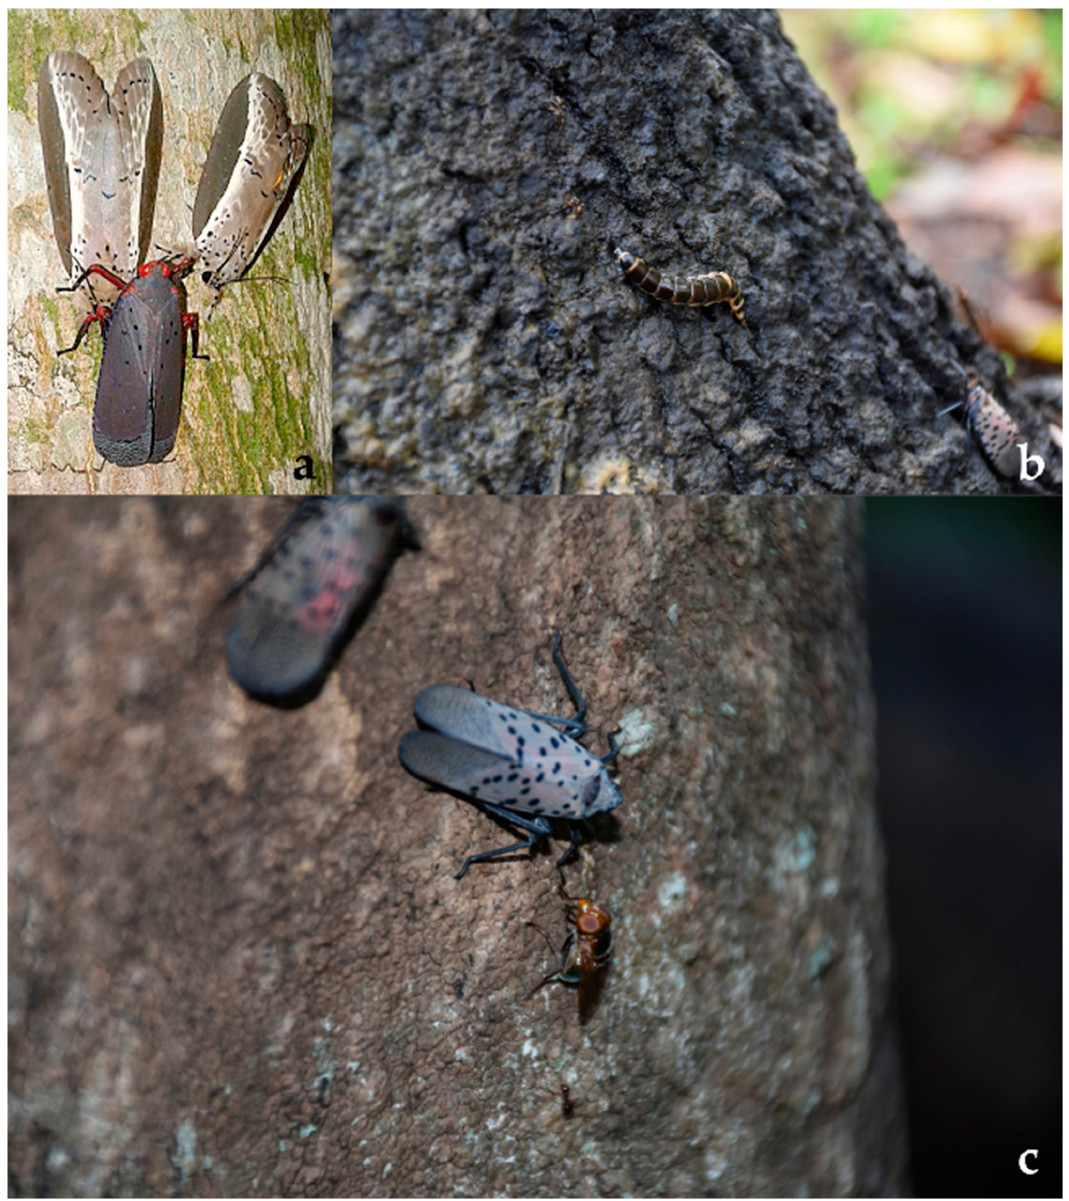
Figure 10. Fulgoridae: ( a ) Kalidasa nigromaculata (Gray, 1832) tended by Lepidoptera: Nolidae: Eligma narcissus (Cramer, 1775), Laos: Vientiane, 17°58 ′ N 102°36 ′ E, 10.08.2017, adult on tree trunk, obs. K. Keomani; ( b ) Lycorma delicatula (White, 1845) tended by Coleoptera indet., USA: Pennsylvania, Berks County, Berks, Oley, 10.10.2017, obs. E. Smyers; ( c ) L. delicatula tended by Diptera indet., USA: Pennsylvania, Berks County, Berks, Oley, 25.09.2017, on tree trunk, obs. E. Smyers.